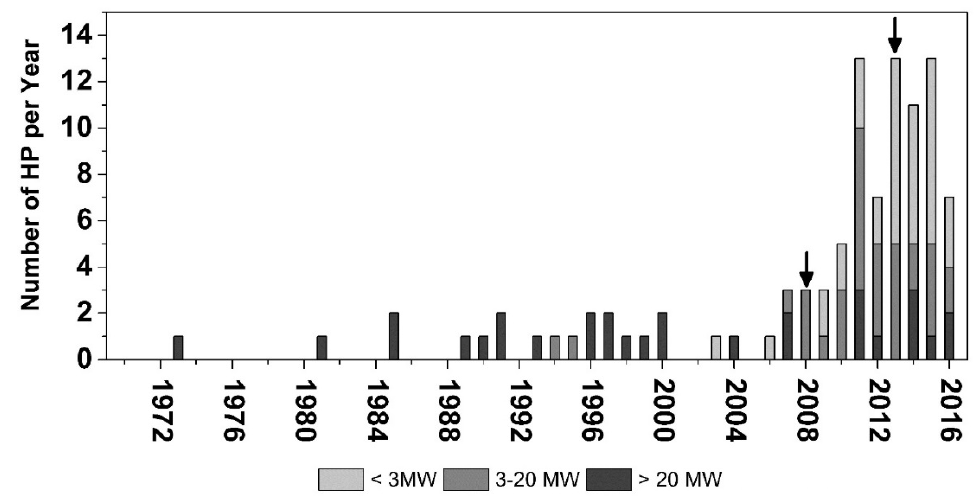
Figure 1. Installed hydropower plants (HP) in Chile between 1970 and 2016. Arrows indicate years of non-conventional renewable energy laws (NCRE) policy implementation. 143